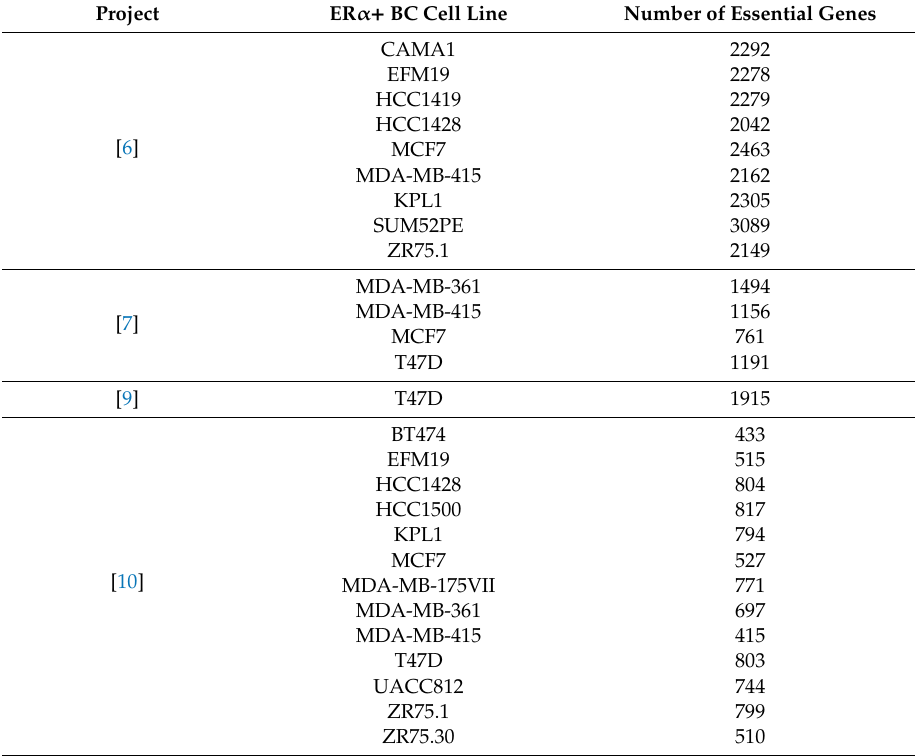
Table 2. Number of essential genes in ER α + breast cancer cell